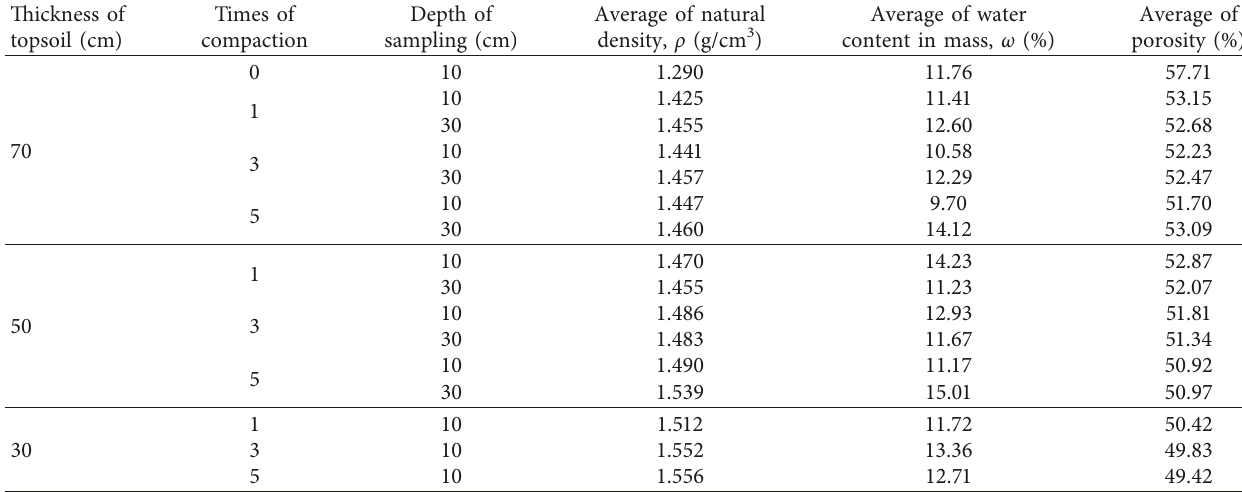
Table 1: Results of the compaction experiment.